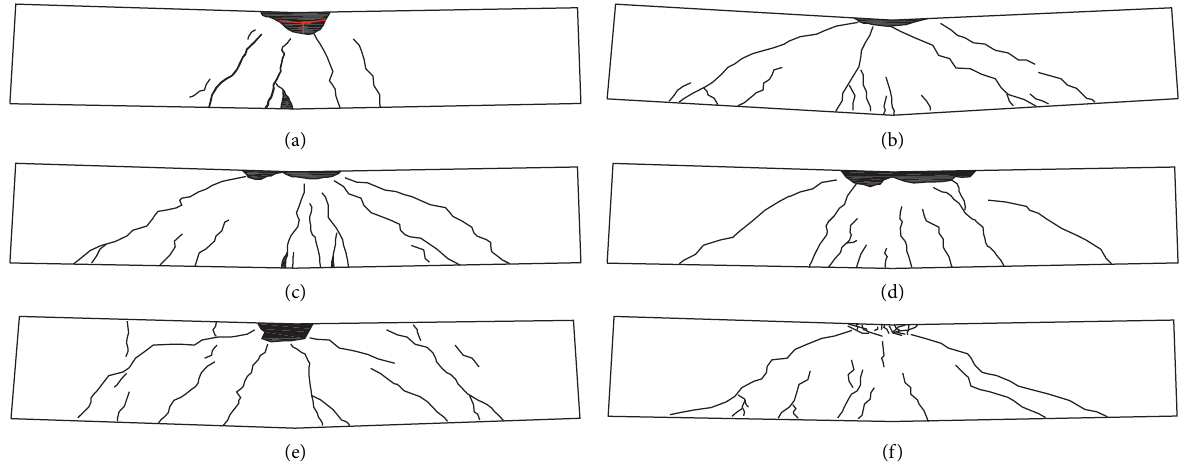
Figure 19: Schematic diagram of the beam damages: (a) L16-1, (b) L16-2, (c) L16-3, (d) L20-1, (e) L20-2, (f)